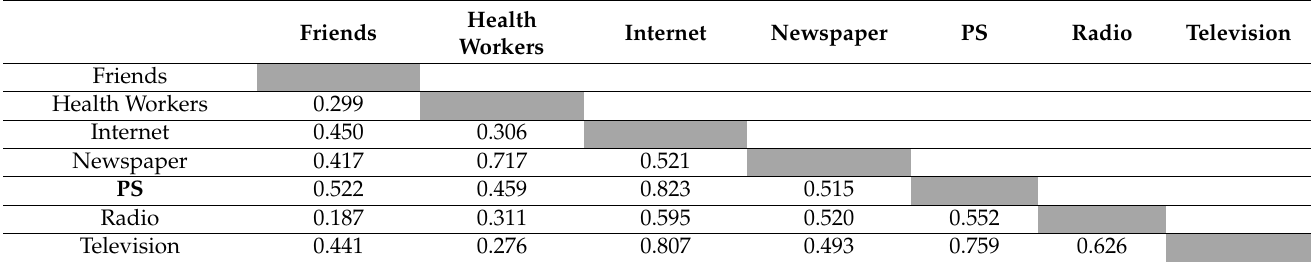
Table 3. Discriminant validity.